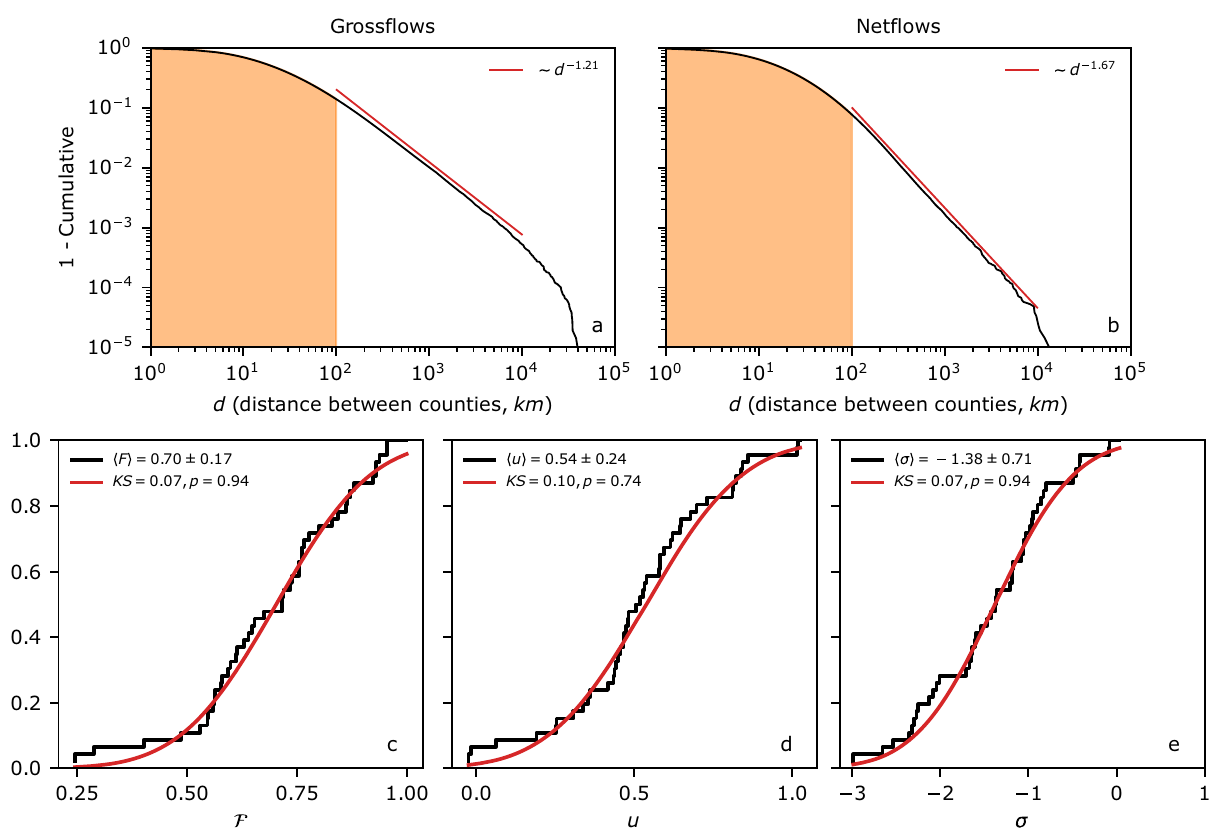
Fig. 2 The highest share of domestic migration is local ( d ≤ 100 km ) in the U.S., and the distributions of intra-city parameters follow a normal distribution. About 86% of the domestic gross fl ows between two counties ( a ) are found within a distance d ≤ 100 km , and about 92.3% of domestic net fl ows is within a 100 km radius ( b ). After d = 100 km, the probability of gross fl ows and net fl ows decay with a power-law with cut-off about 10 4 . We consider distributions of fraction of fl ows from higher to lower density counties F k ( c ), county population ’ s exponent u k ( d ) and distance ’ s exponent σ k ( e ) of all cities k in our system. The empirical distribution of each parameter in black is characterized by mean and standard deviation as shown. The curves in red correspond to the Gaussian pdf with respective mean and standard deviation. The goodness of fi t is addressed by the KS-test, with KS and p values (under the null hypothesis that both distributions are equal) being reported in the city, and blue/green arrows represent inter-city net fl ows ( J p → i − J i → p ) between counties from different cities. In order to model intra-city net fl ows, we hypothesize that